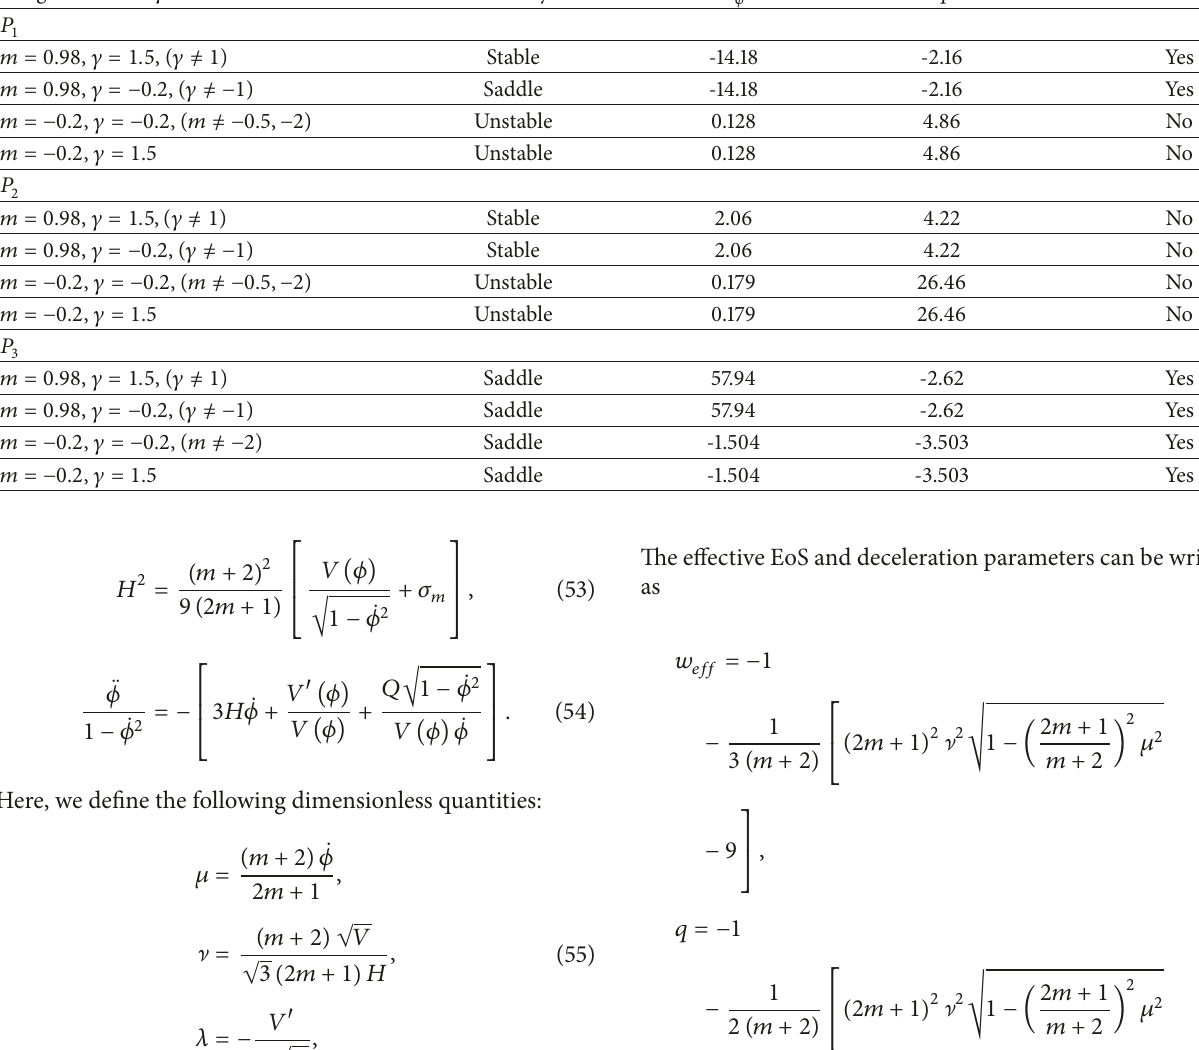
Ranges of 𝑚 and 𝛾 for Critical